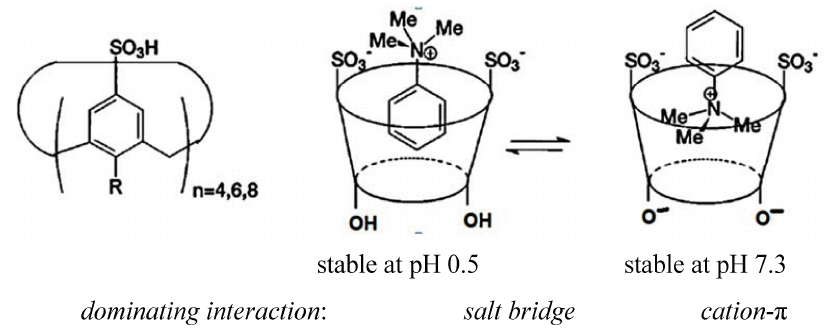
Figure 2. Stereoelectronics: the 1.10-diaza-crown with R = H (diaxial lone pair (lp) orientation, ( A ) binds K + ions with only Δ G = 10 kJ/mol, with R = Me (diequatorial lp orientation; ( B ) Δ G increases to 26 kJ/mol (in methanol) [8].